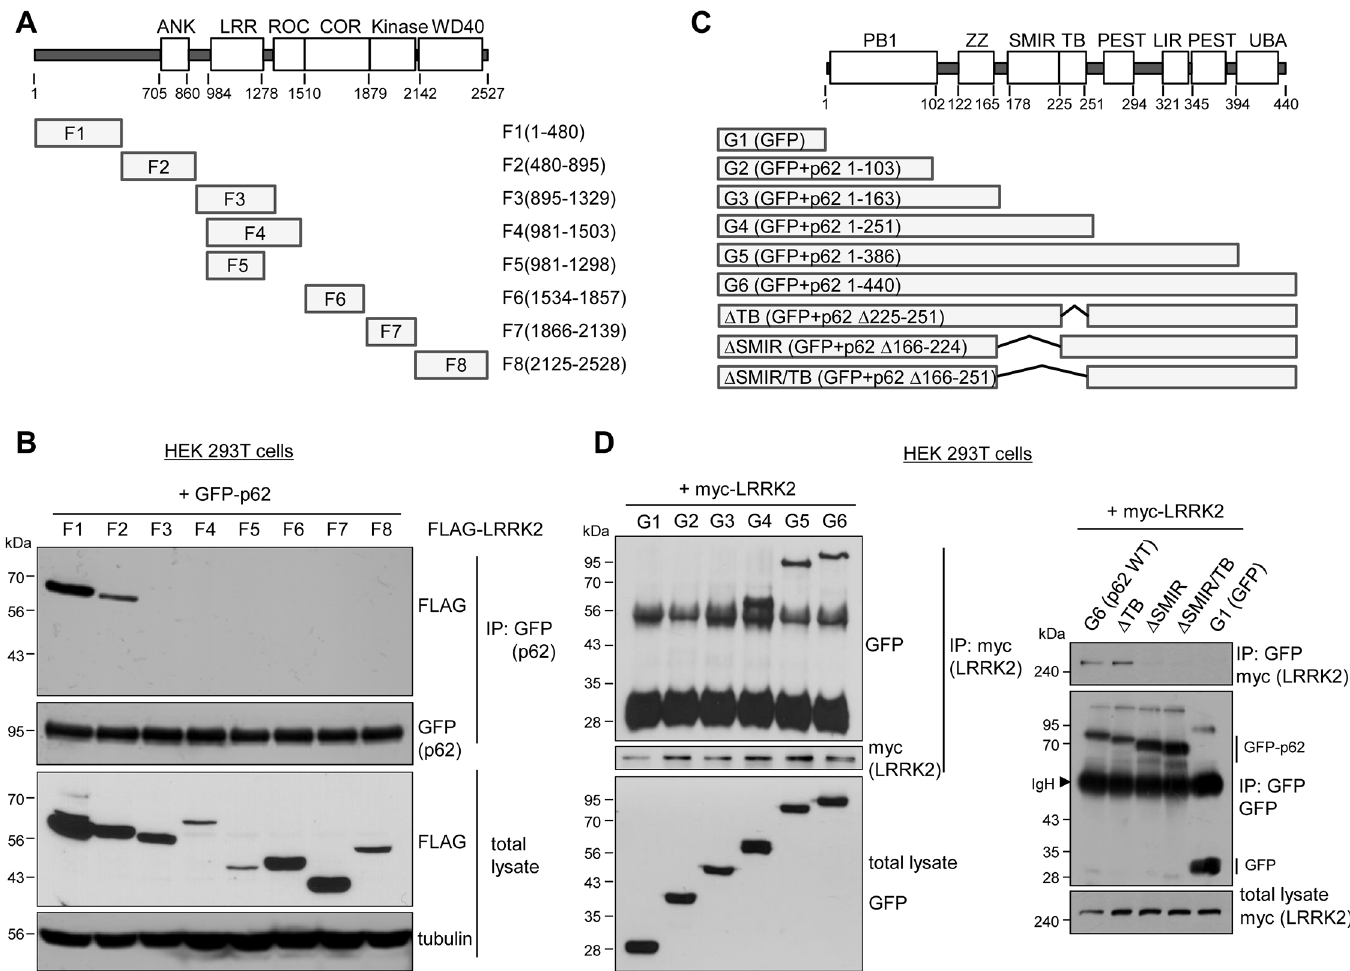
Fig 3. Mapping of the binding domains between LRRK2 and p62. A . Schematic representation showing LRRK2 domains and the LRRK2 fragments (F1-F8) used in panel A. F1: amino acids (aa) 1 – 480, N-terminus segment 1; F2: aa 480 – 895, N-terminus segment 2; F3: aa 895 – 1329, N-terminus segment 3; F4: aa 981 – 1503, LRR + GTPase; F5: aa 981 – 1298, LRR; F6: aa 1534 – 1857, COR; F7: aa 1866 – 2139, kinase; F8: aa 2125 – 2528, WD40 domain. B . p62 interacts the N-terminal region of LRRK2. GFP-tagged p62 was co-transfected with the indicated FLAG-LRRK2 fragment constructs F1 – F8 in HEK 293T cells as shown in panel B. Immunoprecipitation was carried out by using rabbit anti-GFP antibody, and the binding domains were detected with mouse anti- FLAG antibody. C . Schematic representation showing p62 domains and p62 fragments (G1-G6) used in panel A. G1: GFP alone; G2: aa 1 – 103, p62 Phox and Bem1 (PB1); G3: aa 1 – 163, p62 PB1 and zinc finger (ZZ); G4: aa 1 – 251, p62 Δ LIR/ Δ UBA; G5: aa 1 – 386, p62 Δ UBA; G6: aa 1 – 440, p62 full length. Δ TB, Δ SMIR, Δ SMIR/TB indicate the deletion mutants of p62 aa 225 – 251, aa 166 – 224, aa 166 – 251, respectively. All mutant constructs were